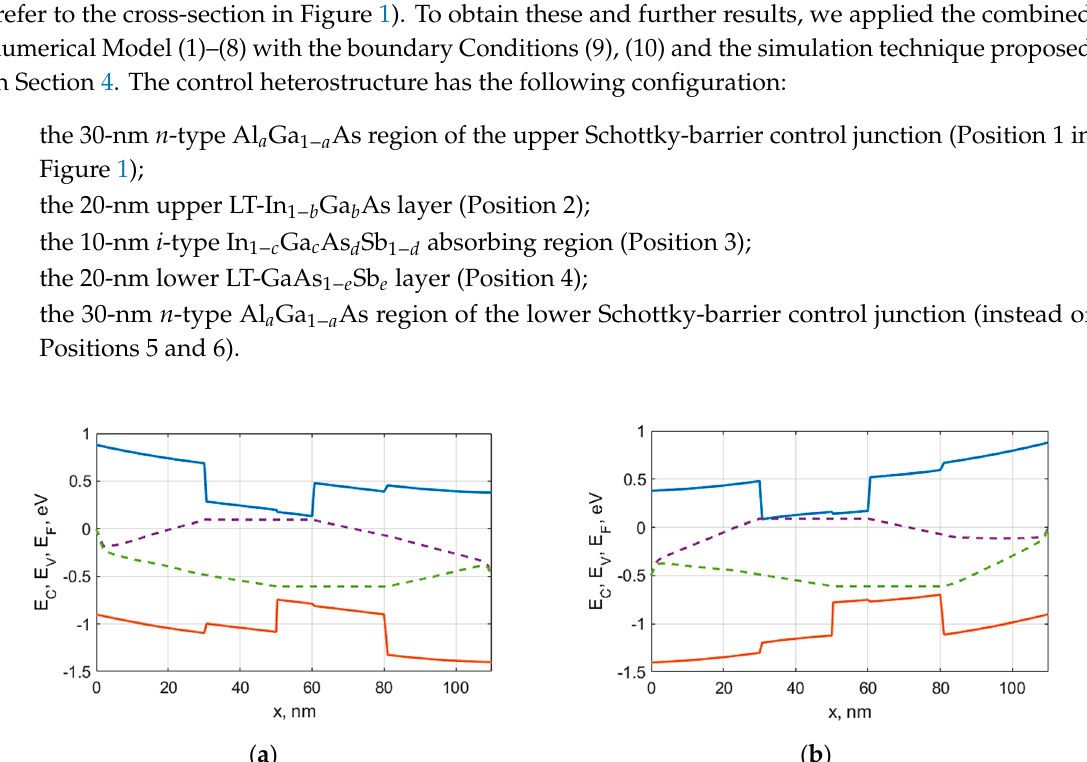
Figure 4. The probability densities (solid lines) of electron ( a ) and hole ( b ) location in the control heterostructure (10-nm LT/5-nm i -type/10-nm LT configuration) at the end of the carrier relocation process. The profiles of the valence band top and conduction band bottom (dashed lines) are given for reference.